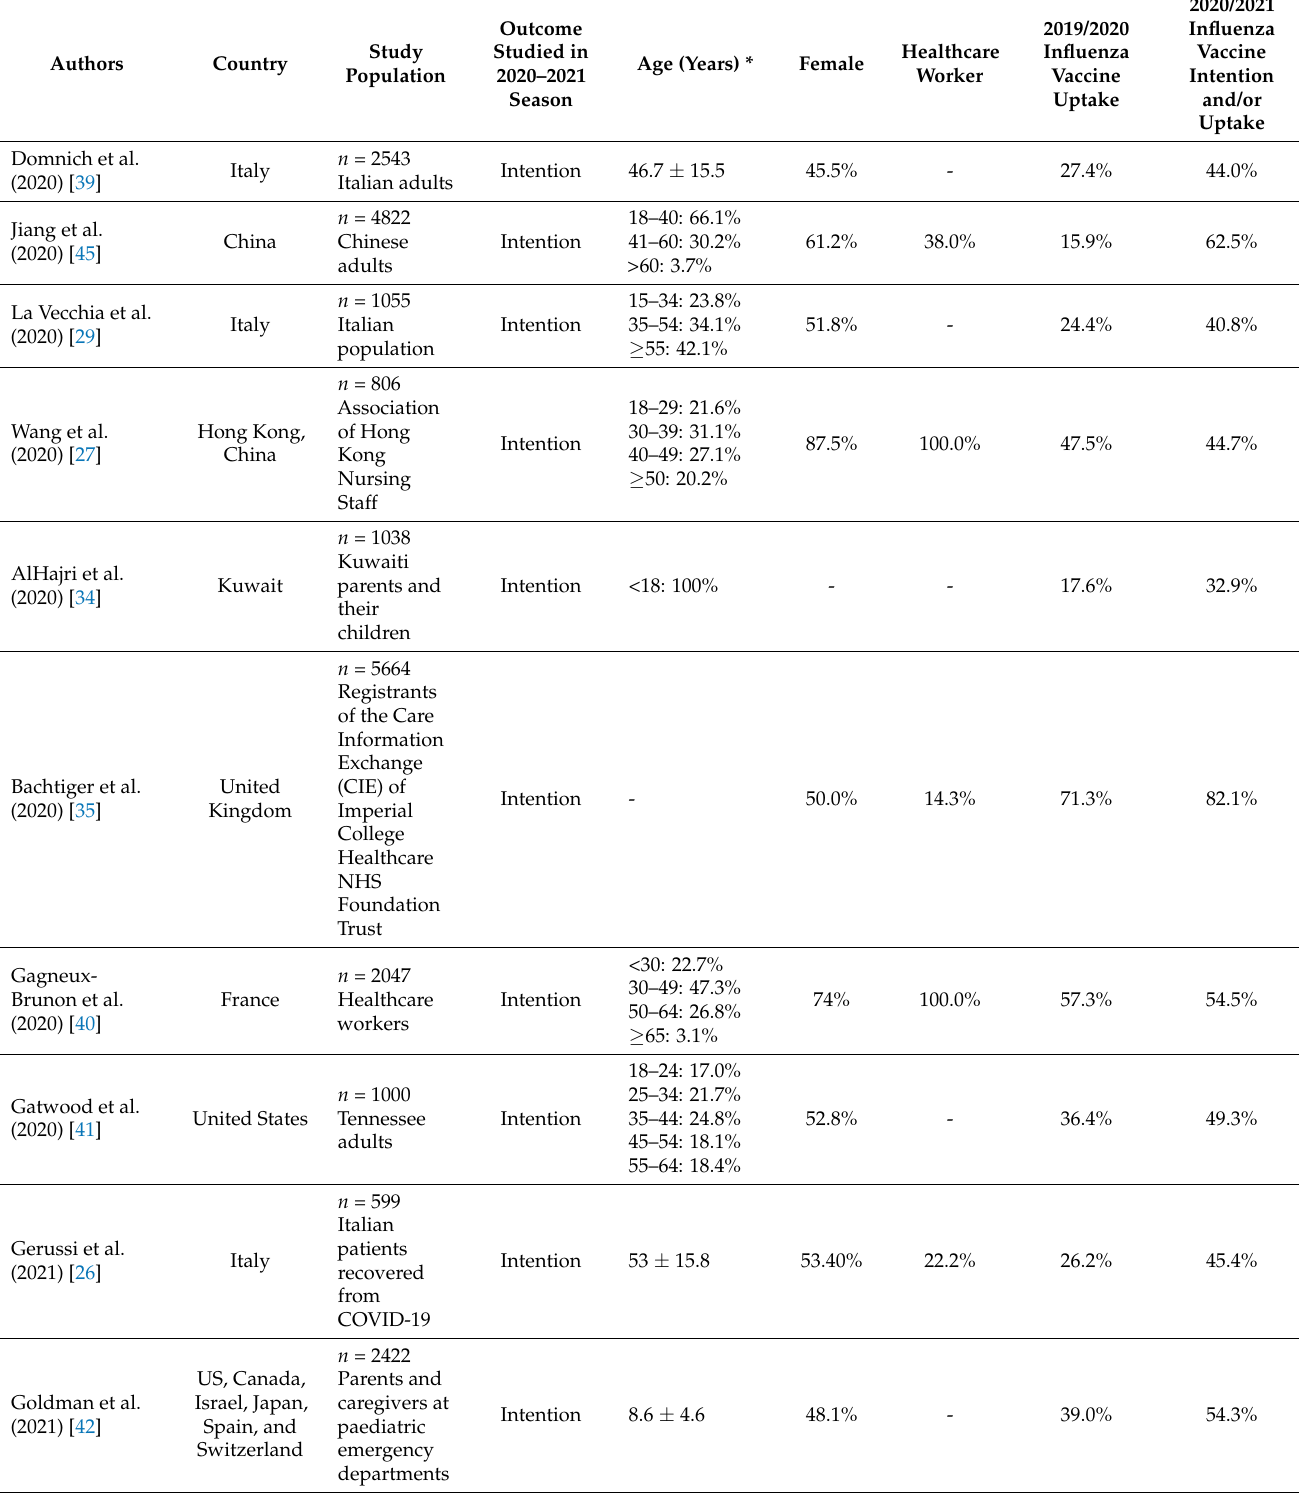
Table 1. Summary of baseline characteristics of included